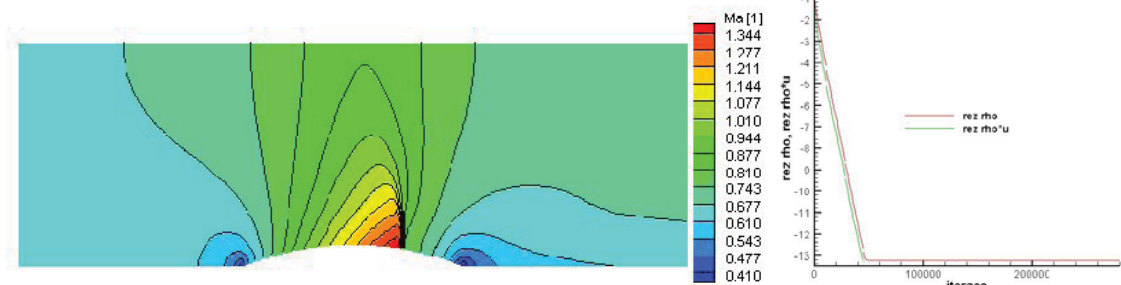
Figure 5: Inviscid compressible flow in the G AMM channel: Mach number isolines (left) and L 2 logarithmic residuals (right) at M 1 = 0 . 675 – RK scheme, IBC A [ M max = 1 . 39 ], a structured non- orthogonal grid with 240 × 50 cells.